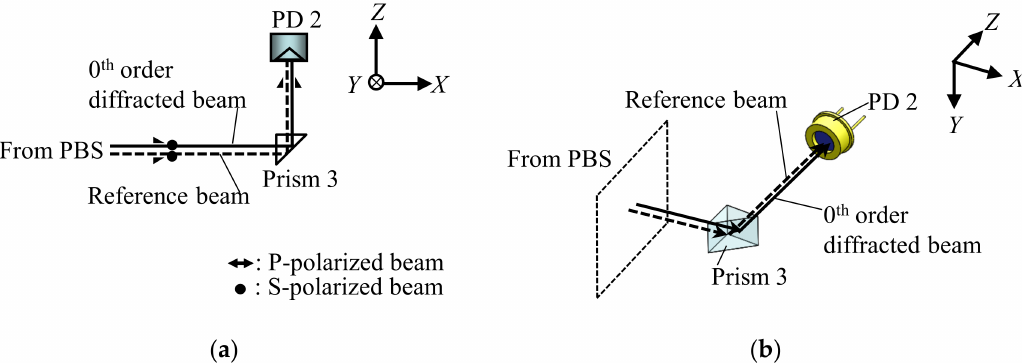
Figure 3. The optical design of ∆ z -assembly: ( a ) XZ view; ( b ) three-dimensional